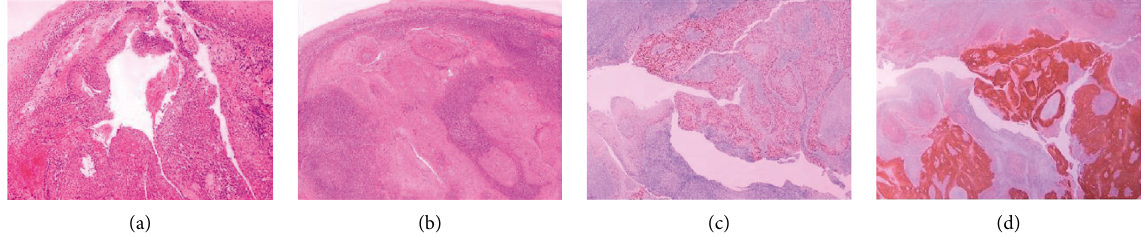
Figure 2: Crypt of the left palatine tonsil lined by squamous cell epithelium lining showing areas of dysplasia and progression (a) to infiltrative moderately differentiated keratinizing carcinoma in the form of solid coalescent aggregations with foci of keratinization and comedo necrosis neoplastic squamous cells with frank atypia (b). Immunohistochemically, the neoplastic cells were positive for p63 (c) and showed strong and diffuse positivity for p16 (d). Hematoxylin and eosin-stained slides of the left palatine tonsil (a–d) at x20 (b, c, and d) and x40 (a) magnification.